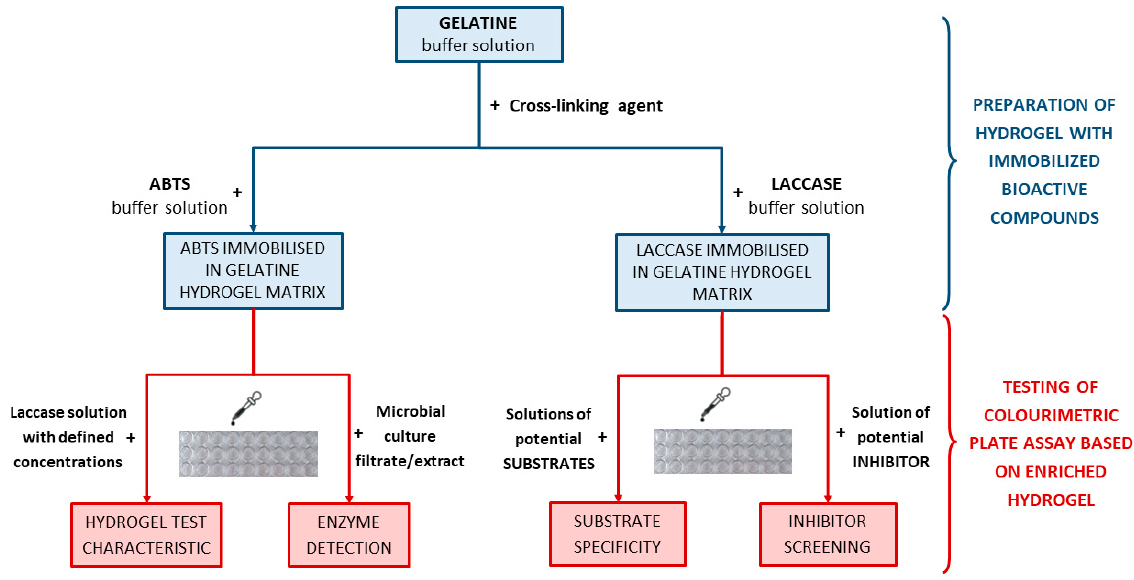
Figure 1. Scheme of research on the development of hydrogel-based colourimetric tests for various screening purposes in enzymology using laccase as the model biocatalyst.